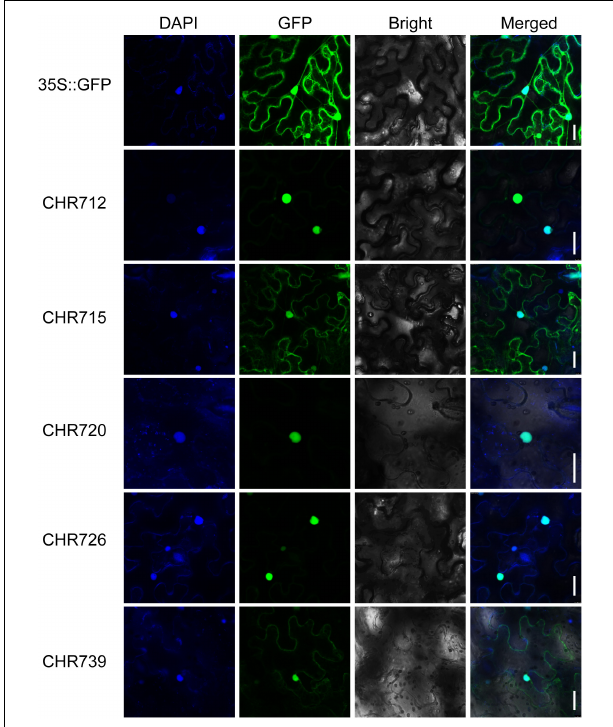
FIGURE 4 | The subcellular localization of OsCHR712/715/720/726/739. The 35S:OsCHR712/715/720/726/739-GFP and control vector (35S:GFP) were transiently expressed in tobacco epidermal leaf cells. Confocal microscopy images were visualized after 24-h transformation. Bar = 30 µ